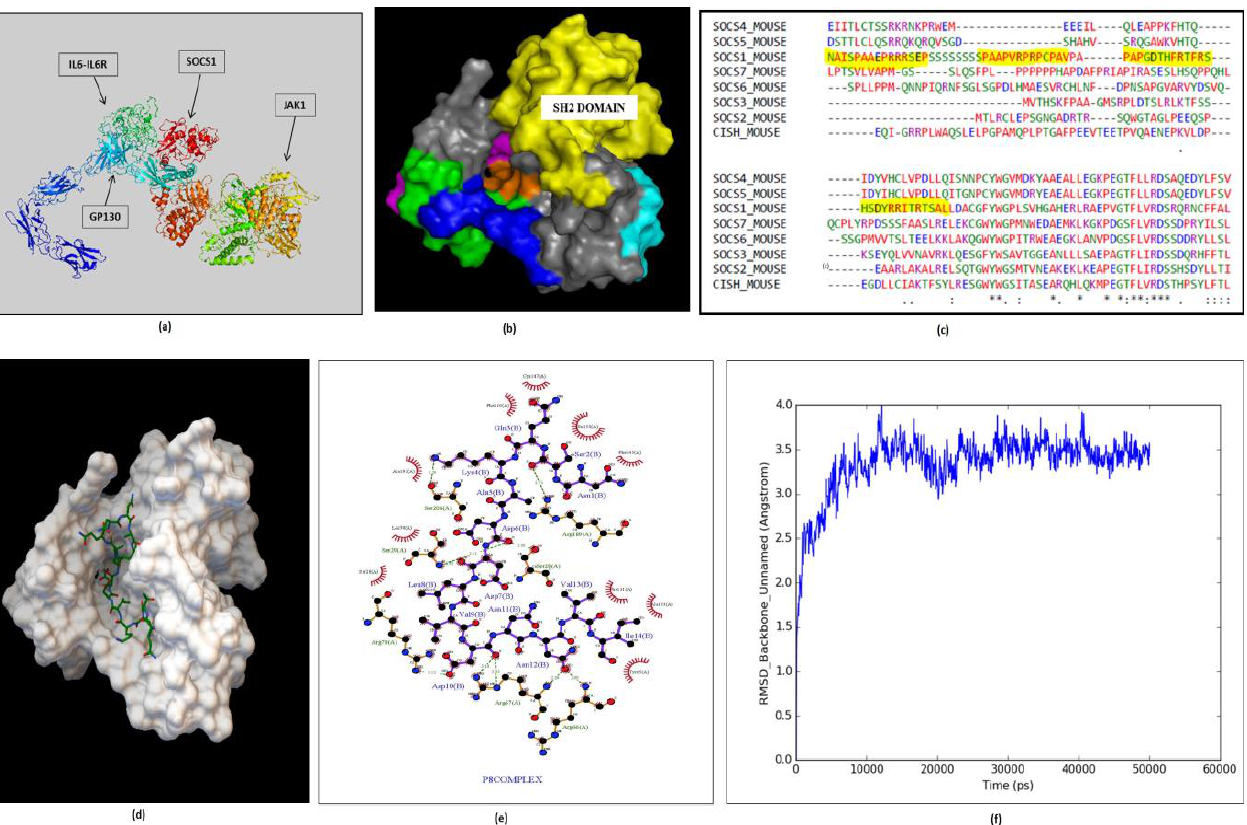
Figure 6. Peptide designed against SOCS1protein: ( a ) Protein–protein docking of IL6-IL6R-gp130 complex with JAK1 and complex with JAK1 and SOCS1 to identify interfacial residue during interaction. (BioLuminate SOCS1 to identify interfacial residue during interaction. (BioLuminate Package, Schrödinger Release 2017-3 Suites). ( b , c ) Package, Schrödinger Release 2017-3 Suites). ( b , c ) Multiple sequence alignment identified Multiple sequence alignment identified non-conserved regions near the SH2 domain of SOCS1 protein as a target for peptide design. ( d ) The complex shows that peptide 8 has been docked at desired region near SH2 domain t hat may inhibit the interaction of SOCS1 and gp130 (Autodock v1.5.6) ( e ) Interaction plot of SOCS1 and Peptide8 amino acid residues (Ligplot+). ( f ) Molecular dynamics simulation of SOCS1-peptide 8 complexes have been performed for 50 ns depicting RMSD plot with stabilized fluctuations, indicating the stability of the SOCS1-Peptide 8 complex.